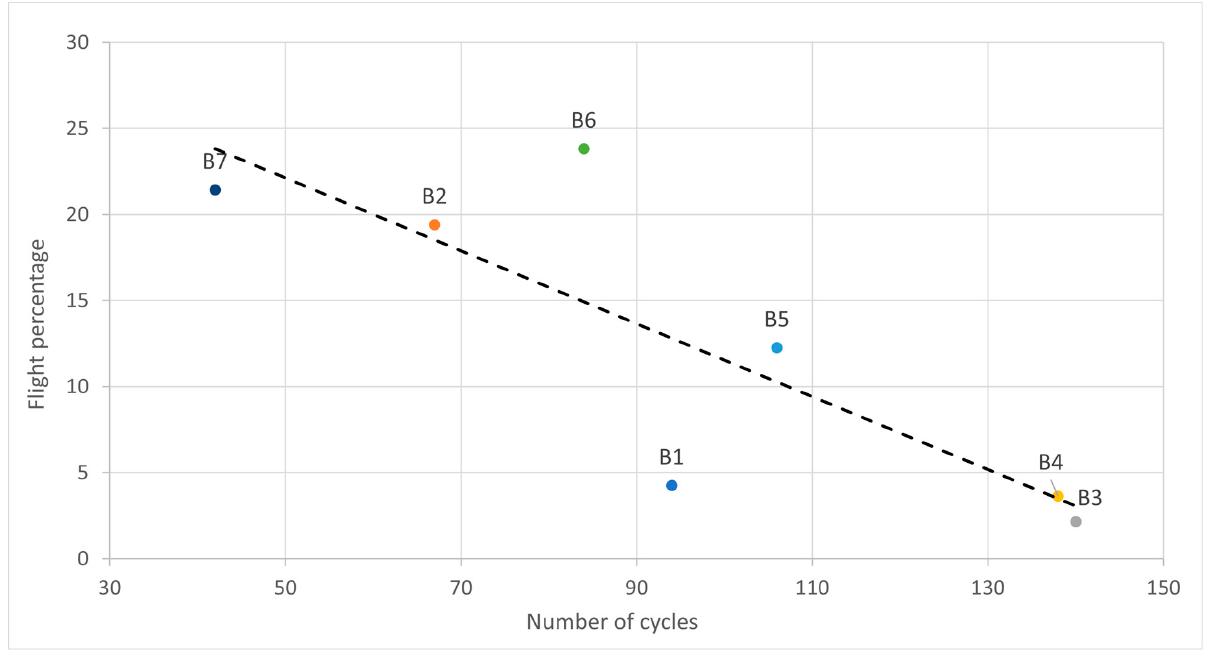
Figure 17. Competition flight percentage vs. cycle life. Due to the trends caused by the discharging rate on aging, it will be one of those included when performing the